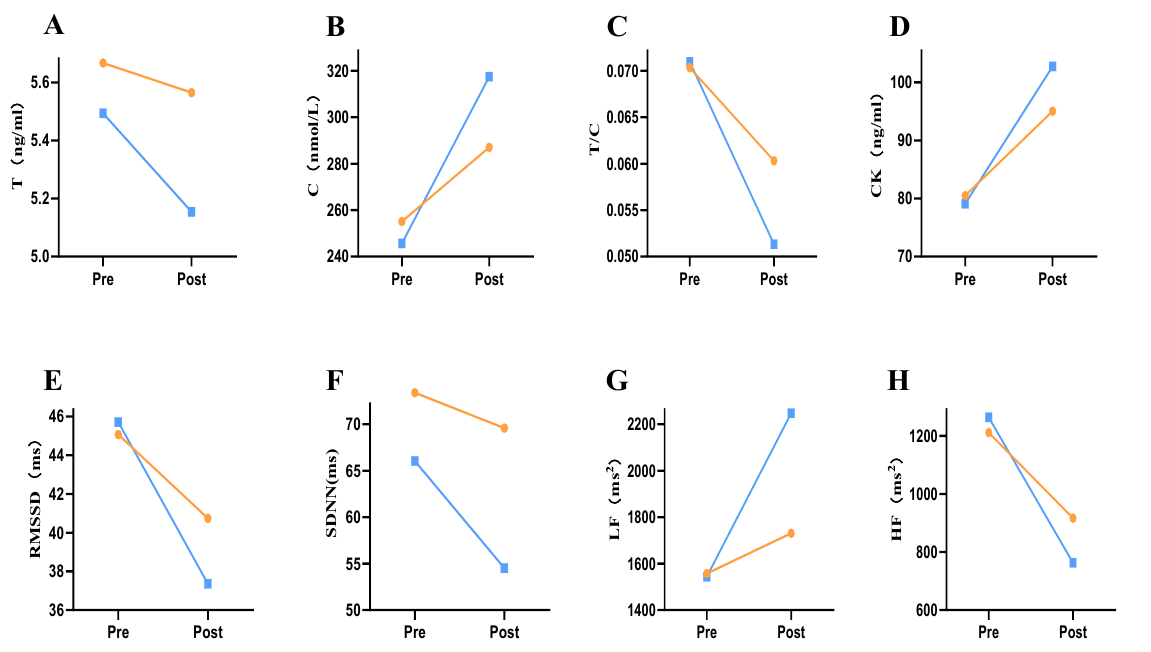
Figure 3. Changes in blood marker values and HRV values before and after tPCS intervention. Note: ( A ): Changes in T values before and after tPCS intervention; ( B ): Changes in C values before and after tPCS intervention; ( C ): Changes in T/C values before and after tPCS intervention; ( D ): Changes in CK values before and after tPCS intervention; ( E ): Changes in RMSSD values before and after tPCS intervention; ( F ): Changes in SDNNs value before and after tPCS intervention; ( G ): Effects of tPCS intervention on LF; ( H ): Changes in HF values before and after tPCS intervention. Pre means before intervention; Post means after intervention.